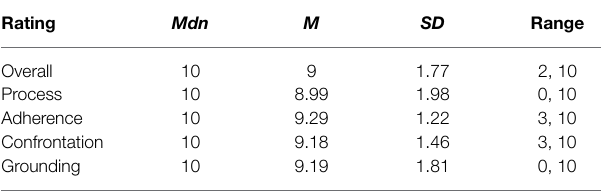
TABLE 2 | Descriptive statistics of different eEMDR ratings.